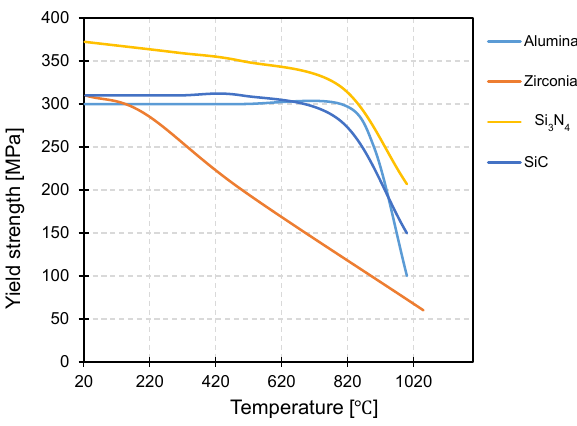
Figure 9: Yield strength vs. temperature for ceramics (based on [27])